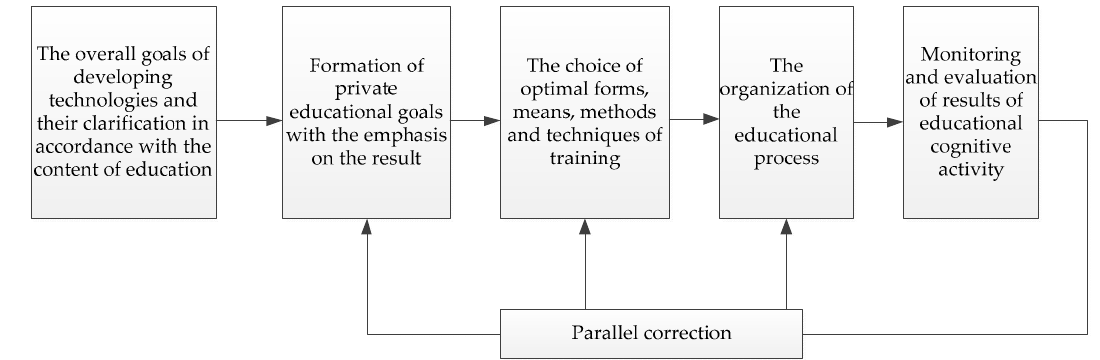
Figure 1. The scheme of educational technology as a process.